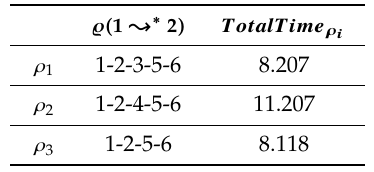
Table 4. Possible paths from node 1 to node 6.